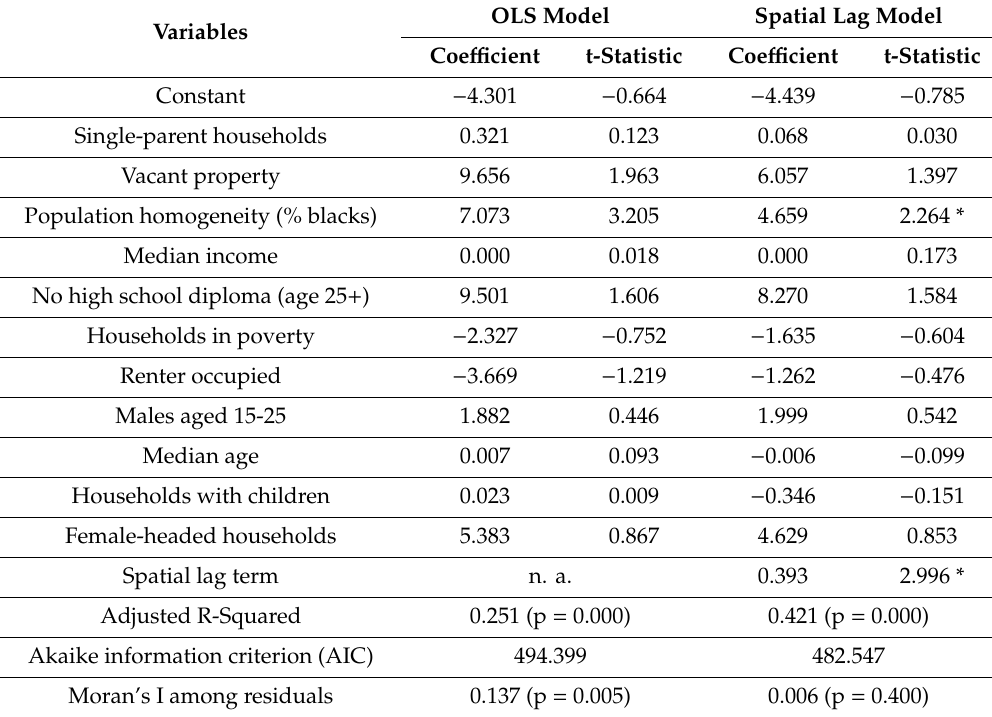
Table 6. Results of OLS and spatial regression analysis for underreported events (n = 82).